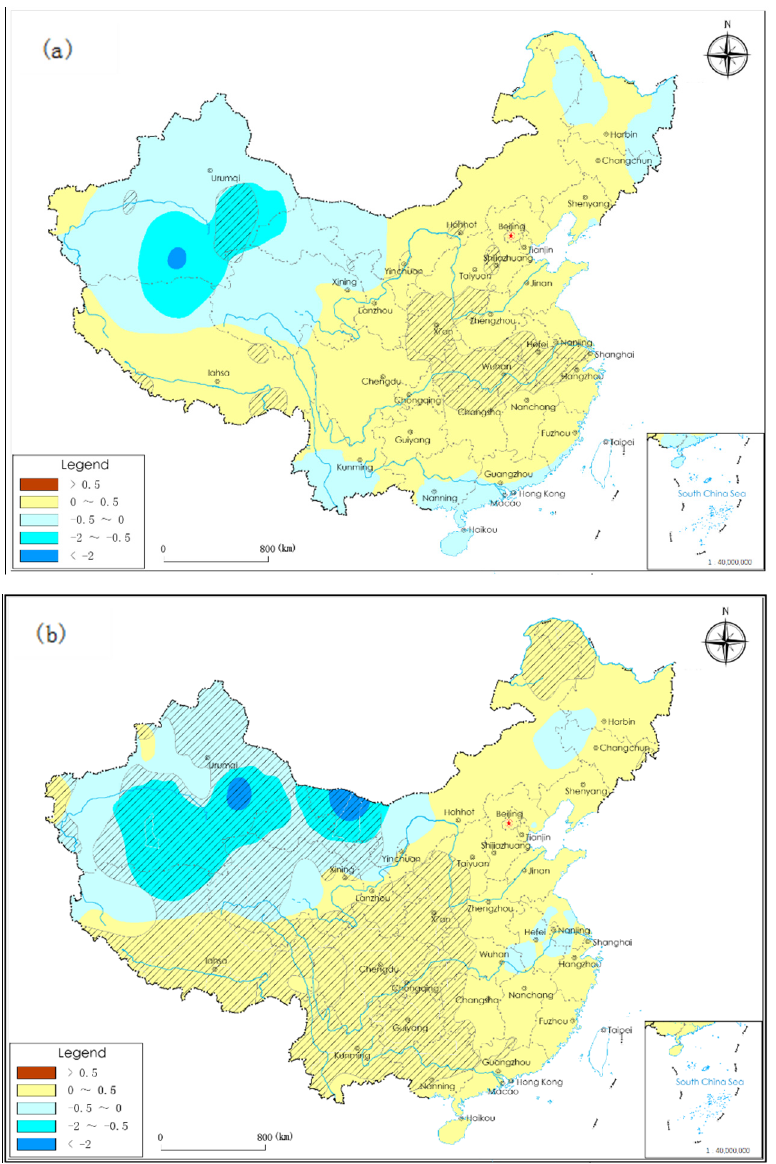
Figure 7. The linear trends of aridity index under RCP4.5 ( a , color filled area); and RCP8.5 ( b , color filled area), the significance test passed the 95% confidence level area ( a and b , slant line area) in China from 2021 to 2099.